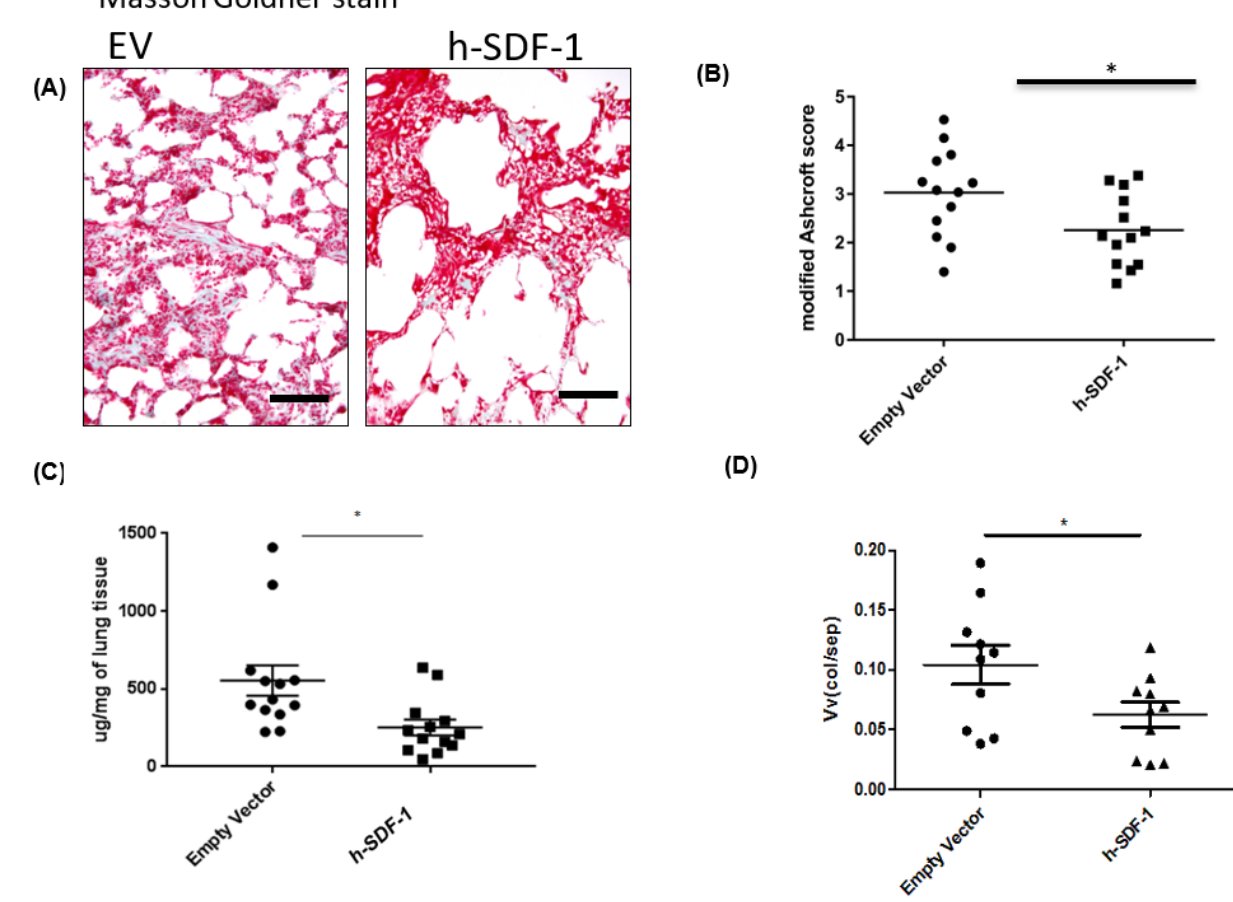
Figure 2. Anti-fibrotic effect of h-SDF-1 overexpression. In vivo electroporation-mediated pSDF-1 gene transfer reduces fibrosis in bleomycin-injured rat lung. Masson–Goldner staining of EV (left) and pSDF-1 (right) treated lung ( A ); assessment of lung fibrosis by modified Ashcroft’s score to grade fibrosis after pSDF-1 gene transfer ( B ); hydroxyproline assay to measure the total collagen content of rat lung after pSDF-1 or EV treatment ( C ); stereology-based assessment of volume fraction of collagen fibrils within septum/parenchyma of the rat lung tissue after pSDF-1 or EV treatment ( D ). ( n = 15; Mean ± SD; *: p < 0.05) (1 animal in h-SDF-1 group died ( n = 14)). ( n = 10 for stereological analysis ( D )).